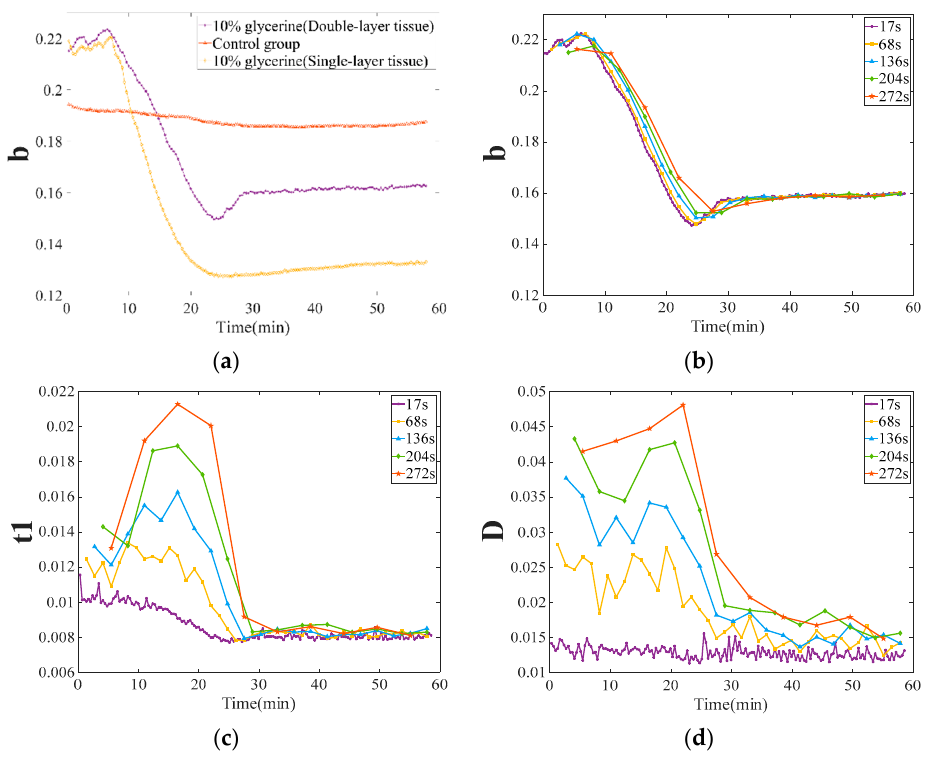
Figure 8. ( a ) Average values of MMT parameter b of different samples: double-layer tissue (porcine skin and adipose layer) with application of 10% glycerin (the blue line), double-layer tissue (porcine skin and adipose layer) without glycerin (the red line) as control and single-layer tissue (adipose layer) with application of 10% glycerin (the yellow line). Average value of parameters for double-layer tissue at different DT MM : ( b ) MMT parameter b , ( c ) MMT parameter t 1 and ( d ) MMPD parameter D . The horizontal axis represents the time after application of 10% glycerin to the double-layer